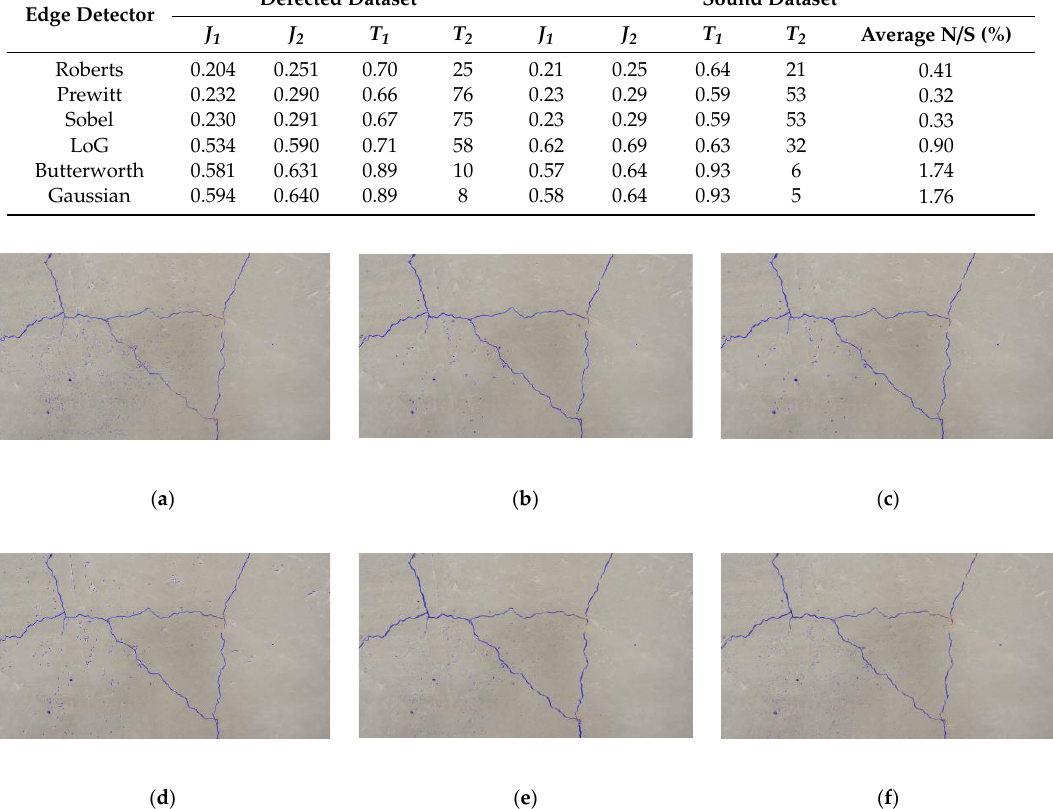
Figure 10. Superimposed second-level binary images on the original image using ( a ) Roberts, ( b ) Prewitt, ( c ) Sobel, ( d ) LoG, ( e ) Butterworth, and ( f ) Gaussian filters.